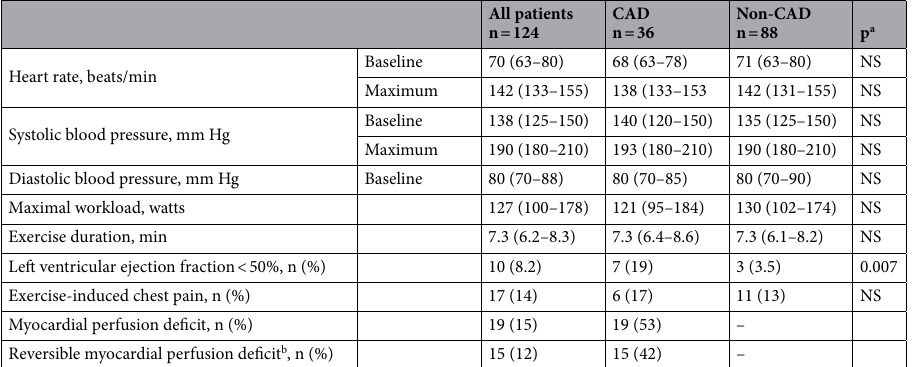
All patients n = 124